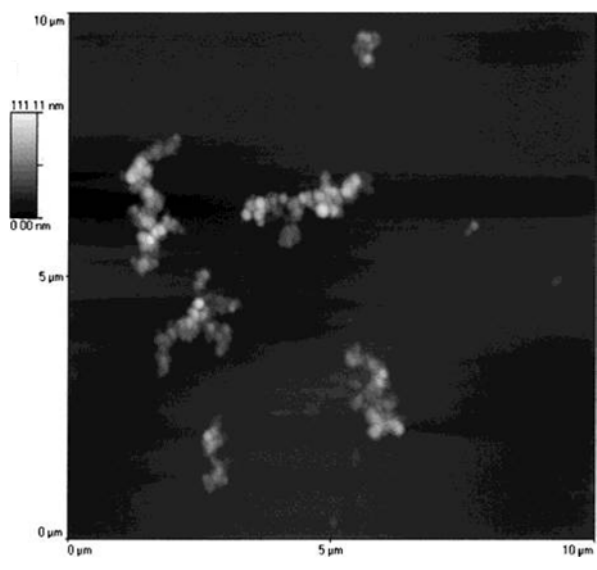
Figure 22. Noncontact mode AFM image of the solid lipid nanoparticles of 15 in the presence of 3 mM CaCl on mica at10 μ m scan size [86]. 2